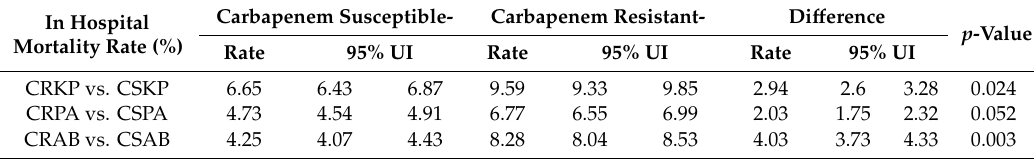
Table 8. In hospital mortality among patients with CRKP and CSKP, among patients with CRPA and CSPA, and among patients with CRAB and CSAB after PSM for potential confounding variables. Carbapenem In Hospital Mortality Rate (%)